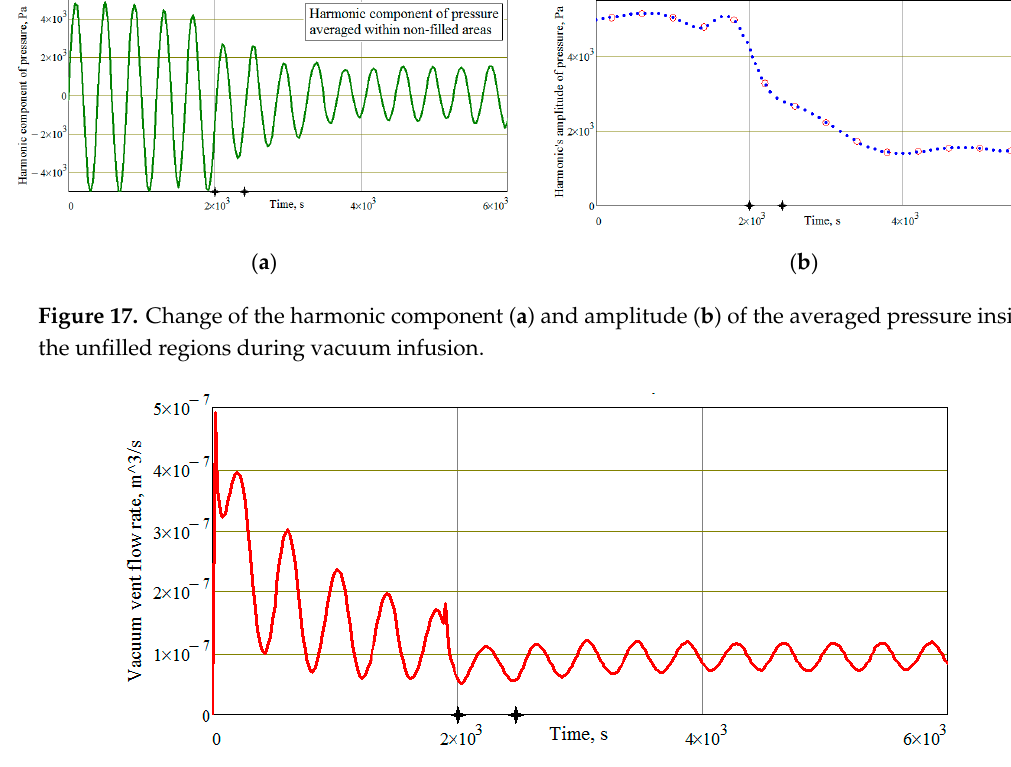
Figure 18. Time history of the vent’s air flow rate during vacuum infusion.